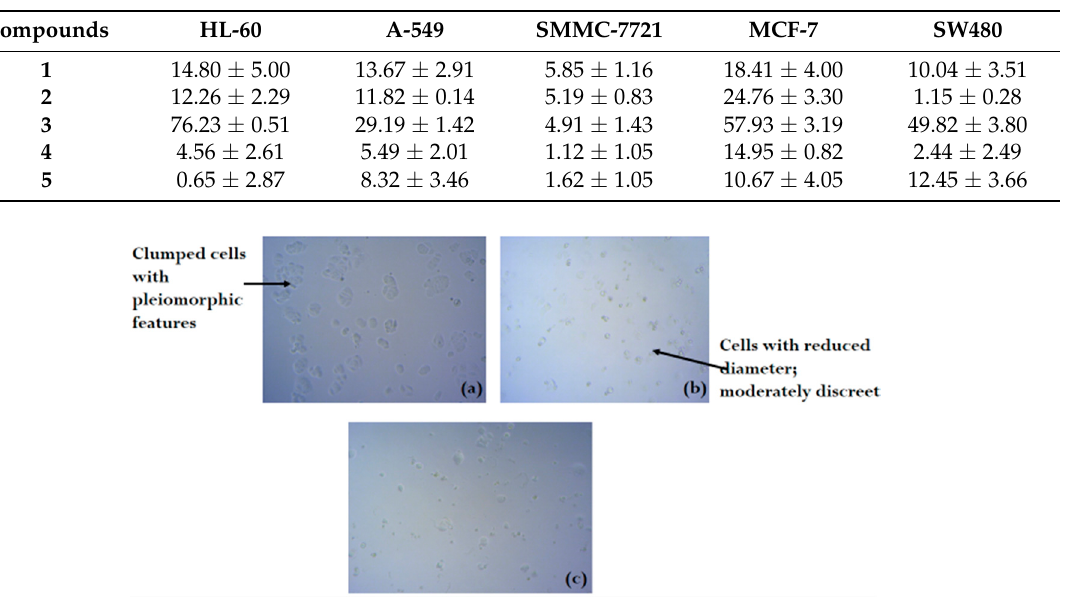
Table 2. Percentage of inhibition (I%) of compounds 1 – 5 (40 μ M) isolated from R. heudelotii on different cell lines.